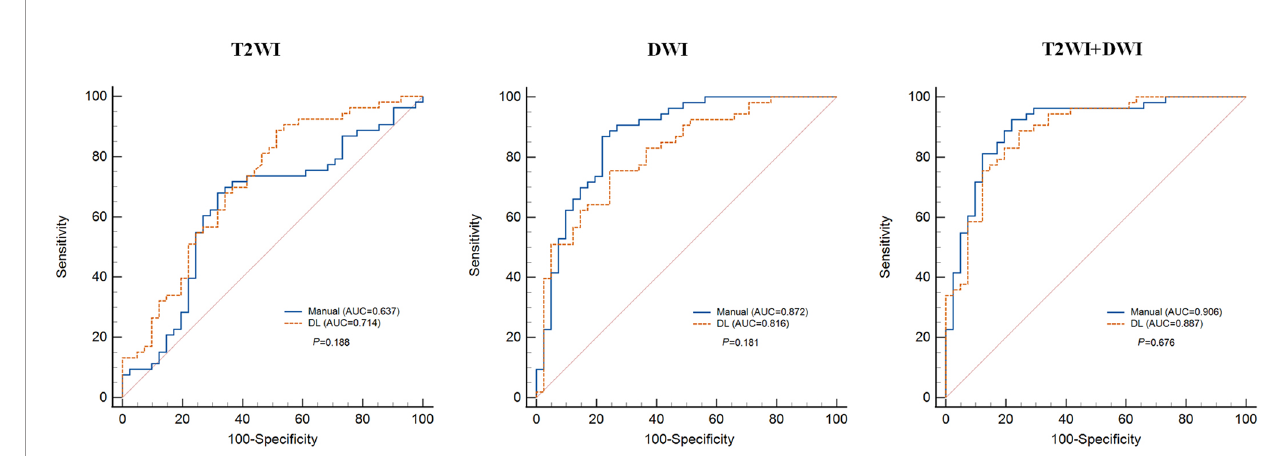
FIGURE 4 | Mean receiver operating characteristics (ROC) curve of fi ve-fold cross validation for each radiomics-based model. DL, deep learning; AUC, area under the